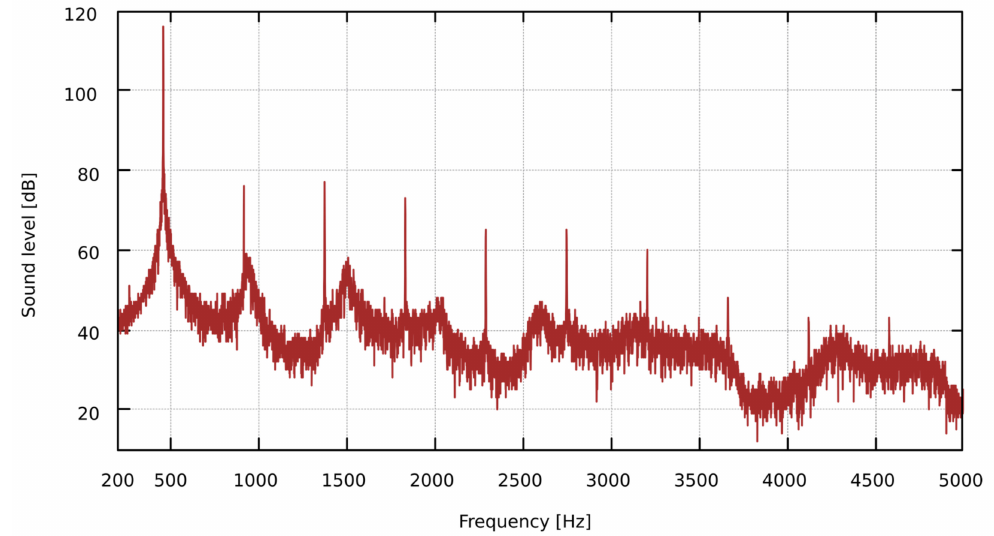
Figure 4. Dolce Flute 4-foot B spectrum for the immediate proximity to the obstacle (0 mm) at the pipe lip. A linear frequency scale has been used to help locate harmonics that are equally spaced on this